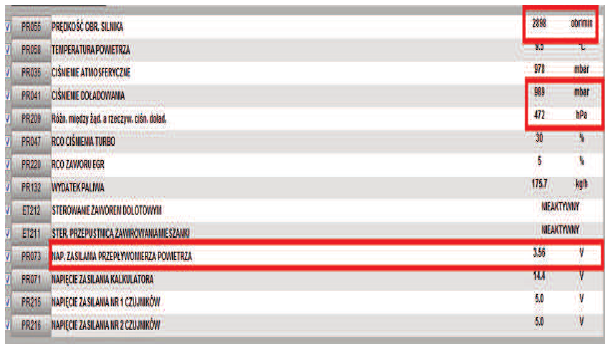
Fig. 3. Low voltage level of the flowmeter measuring system